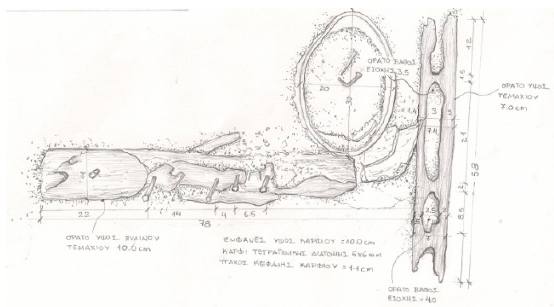
Figure 4: Detailed architectural documentation of important elements, Wreck No 6 , © H.I.M.A., F. Vlachaki